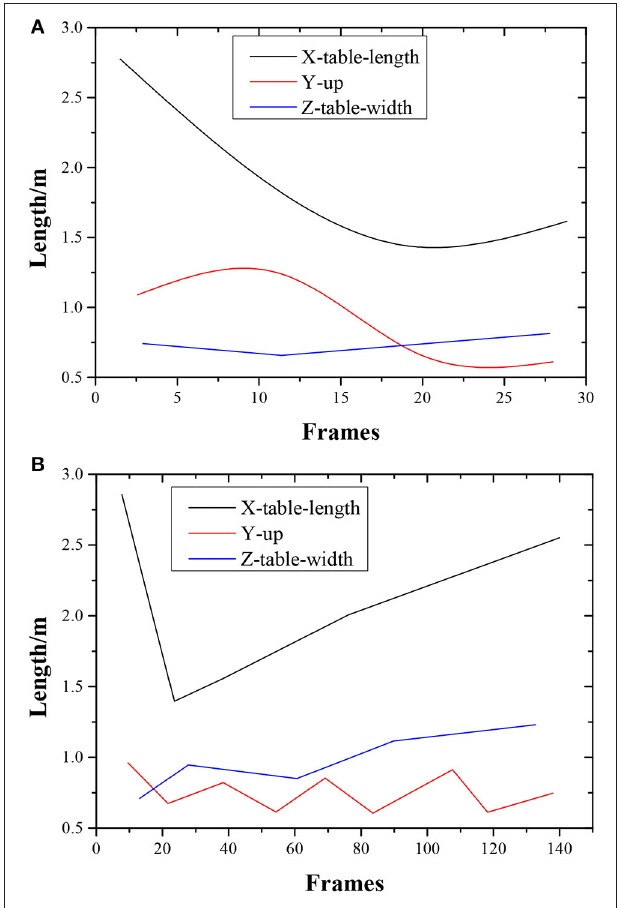
FIGURE 8 | (A) Table tennis trajectory of the serve touching the net. (B) Table tennis trajectory of the missed